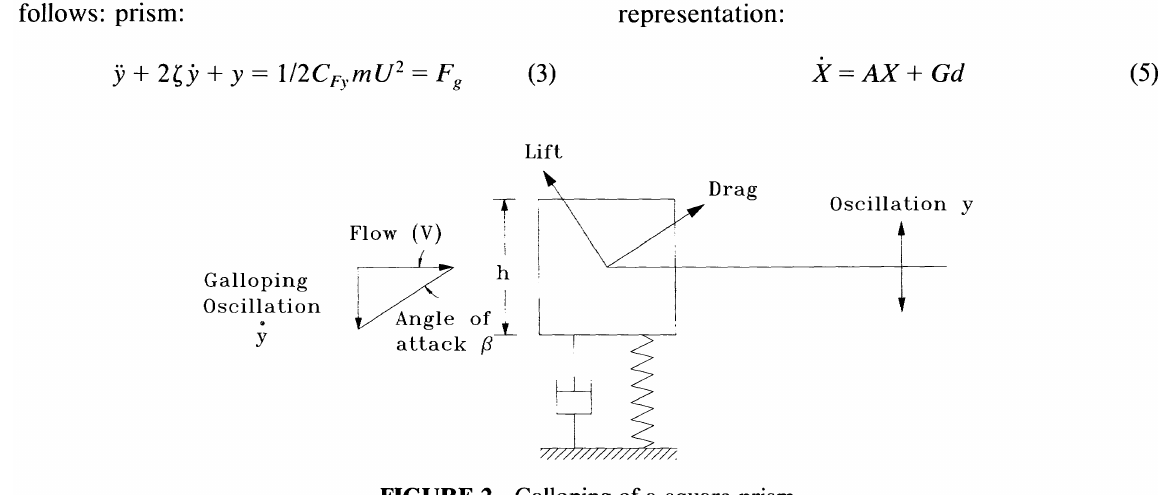
FIGURE 2 Galloping of a square